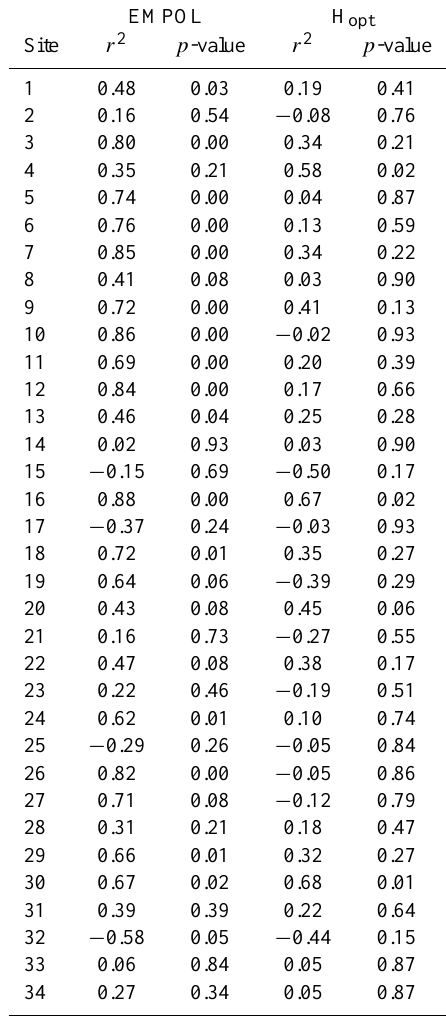
Table 6. Correlation coefficients ( r 2 ) and their corresponding p - values for the two model configurations at each of the measuring sites. The mean r 2 over all stations is 0.43 for EMPOL and 0.12 for H opt . The corresponding mean p -values are 0.19 for EMPOL and 0.49 for H opt